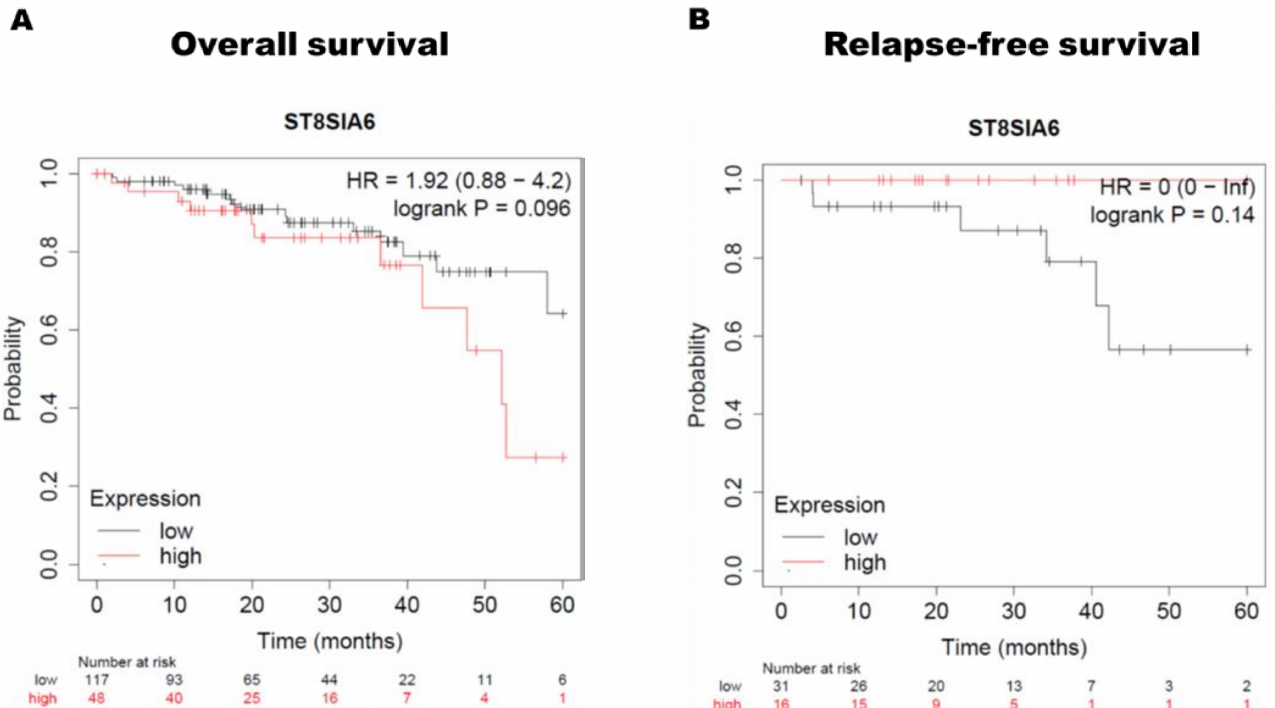
Figure 2. Survival curve analyses show the correlation between ST8SIA6 mRNA expression and ( A ) Overall survival (OS) or ( B ) Relapse-free survival (RFS) in patients with colon cancer. HR = hazard ratio. HR and 95% CI were